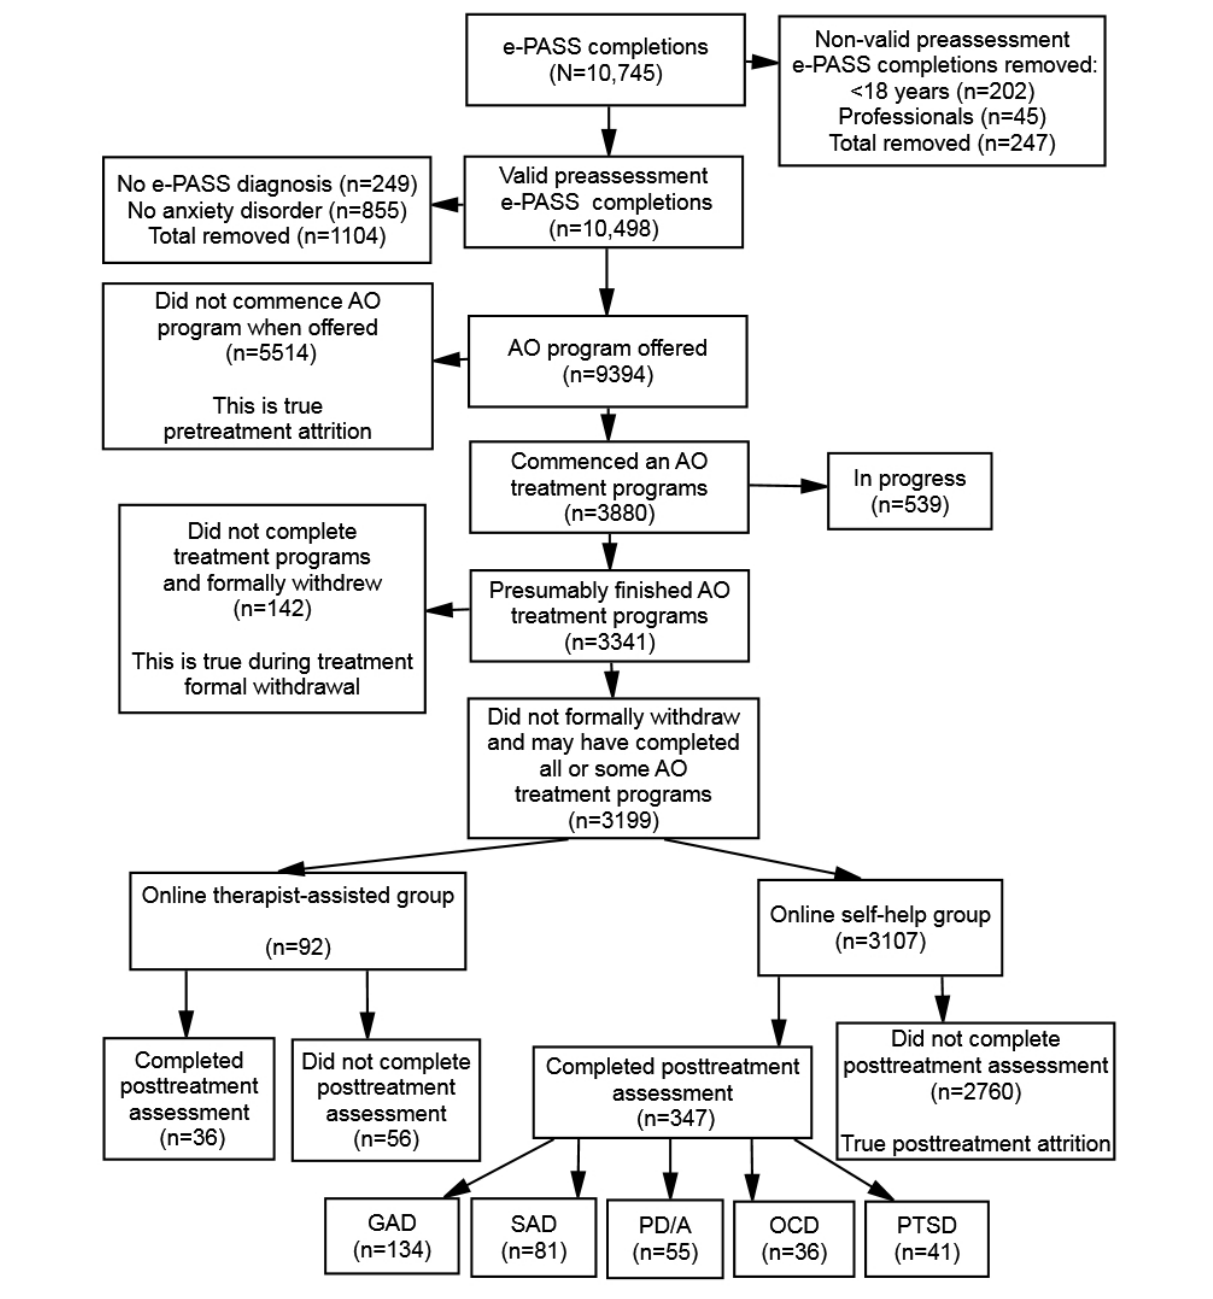
Figure 2. Recruitment and enrollment rate throughout the